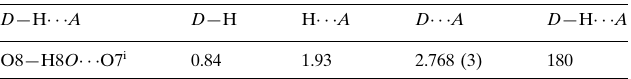
Hydrogen-bond geometry (A˚ , (cid:2)